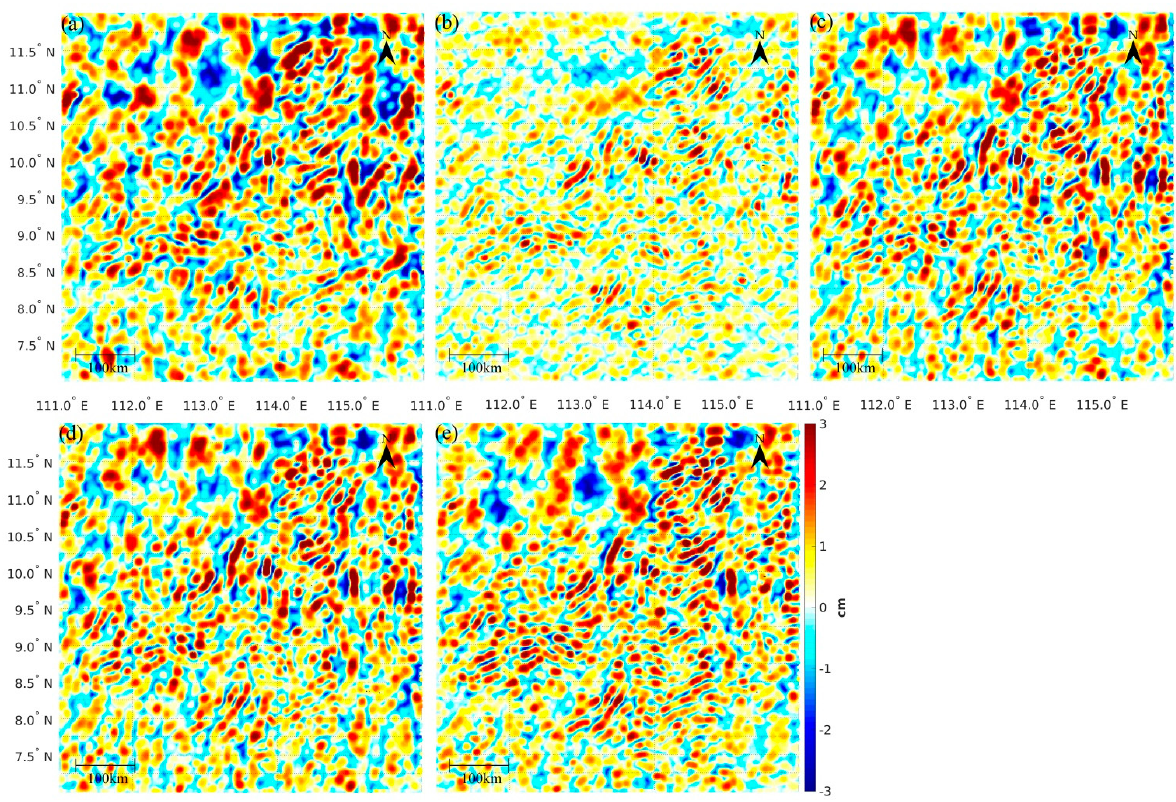
Figure 5. The added signals in terms of quasi-geoid heights modeled with ( a ) HY2A, ( b ) SCSGA, ( c ) SIO30, ( d ) SIO31, and ( e ) DTU21GRA. The geographical coordinates are expressed in the Plate Carrée projection. Note: only SIO30, SIO31, and DTU21GRA were computed with the SAR altimetry data derived from Sentinel-3A/B over the study area.